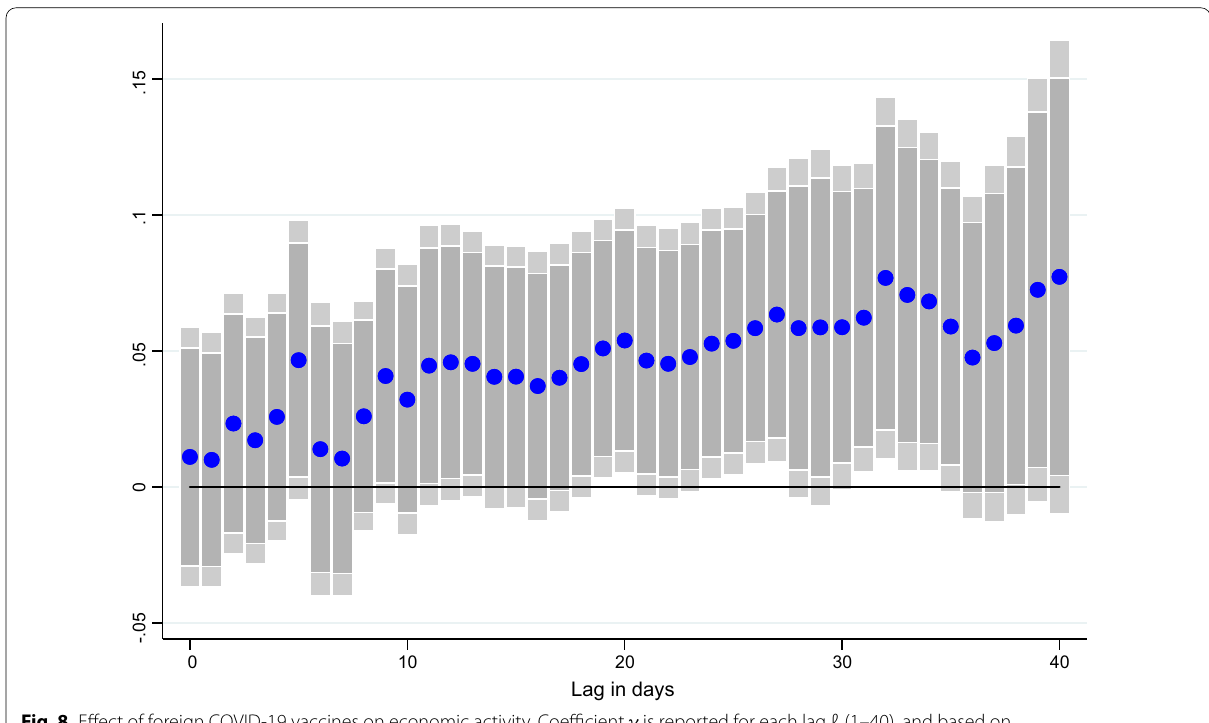
Fig. 8 Effect of foreign COVID-19 vaccines on economic activity. Coefficient γ is reported for each lag ℓ (1–40), and based on � Y i , t = α + µ i + γ t + β SV i , t − l + γ TradingPartner j , t − m + θ X i , t − l + ε i , t for a sample of 43 countries using daily data from December 20, 2020–June 16, 2021. where Y